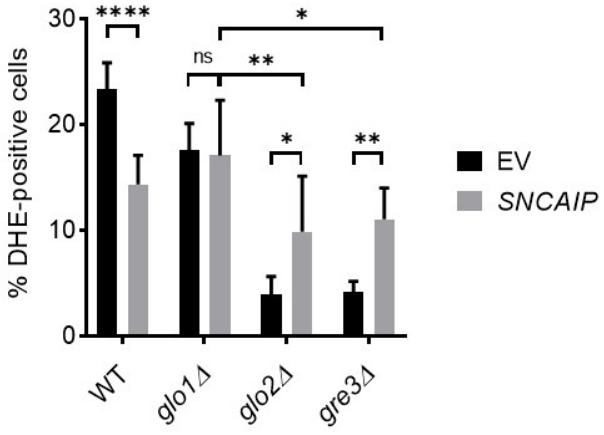
Figure 7. Impact of a disrupted methylglyoxalase system and aldose reductase activity on SY1- associated oxidative stress in S. cerevisiae . Calculated percentages of dihydroethidium (DHE)-positive cells indicate the extent of induced oxidative stress in each strain. Data represent the combined results of cells of five clones per strain. Error bars represent the standard deviations based on DHE- positive cell counts of these clones. Significance is based on the total number of cells counted and determined using two-way ANOVA analysis ( p -value of 0.05, significance indicated by the asterisk; n = 5, * = p < 0.05, ** = p < 0.01, **** = p < 0.0001). Non-indicated differences between strains are not significant. DHE = dihydroethidium; EV = empty vector; ns = not significant.